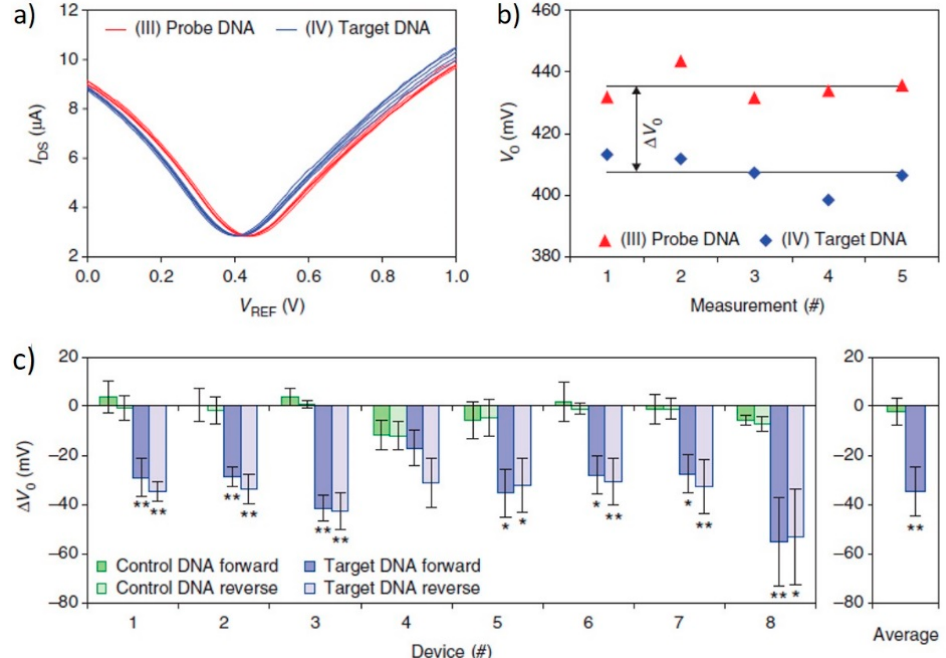
Figure 6. ( a ) Dirac (V g –I DS ) curves for a single G-FET device before and after 100 fM miRNA target exposure. A total of five forward and reverse sweeps were performed on a single device. ( b ) V D values for each sweep calculated from the graphs depicted in ( a ). ( c ) ∆ V D values noted for all eight G-FETs on exposure to the target DNA sequence and to the control DNA sequence. It can be noted that the response seen for the control DNA is considerably less than that caused by the target DNA. For the data highlighted here: * p < 0.05; ** p < 0.01, not significant. Adapted by permission from Macmillan Publishers Ltd.: [45], copyright 2014.